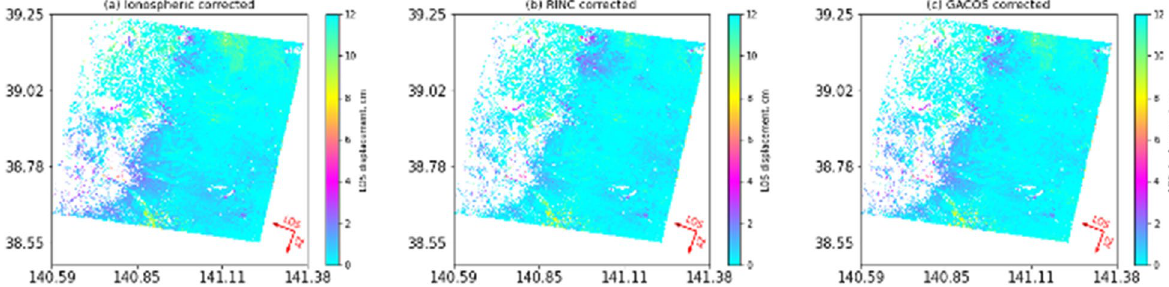
Fig. 8 a Example of an ionosphere-corrected interferogram in the Tohoku region. b Interferogram with GACOS correction applied on a . c Interferogram with RINC correction applied on a . The decorrelated parts shown in these interferograms were excluded from the statistical comparison. The primary image was obtained on January 15, 2015. The secondary image was acquired on February 12,